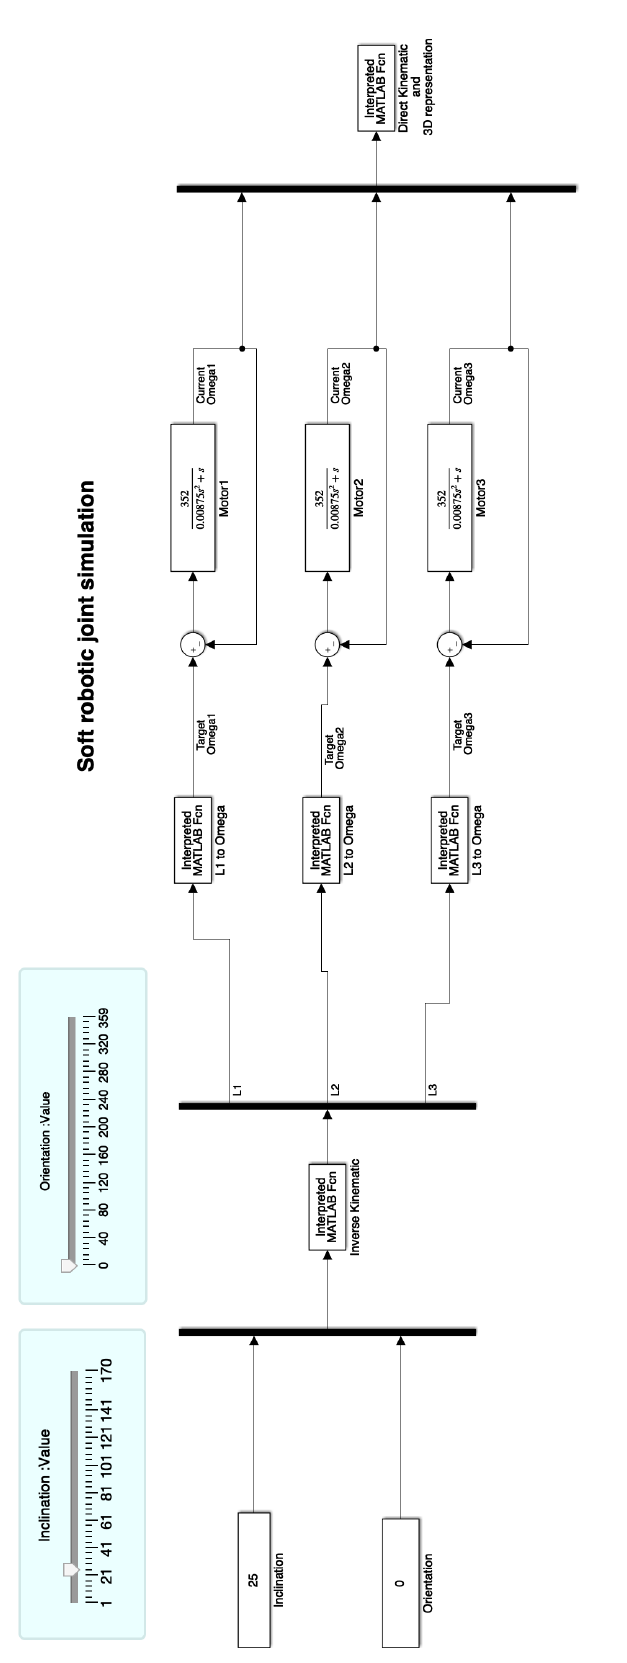
Figure 16. Simulink schematic for the soft joint model